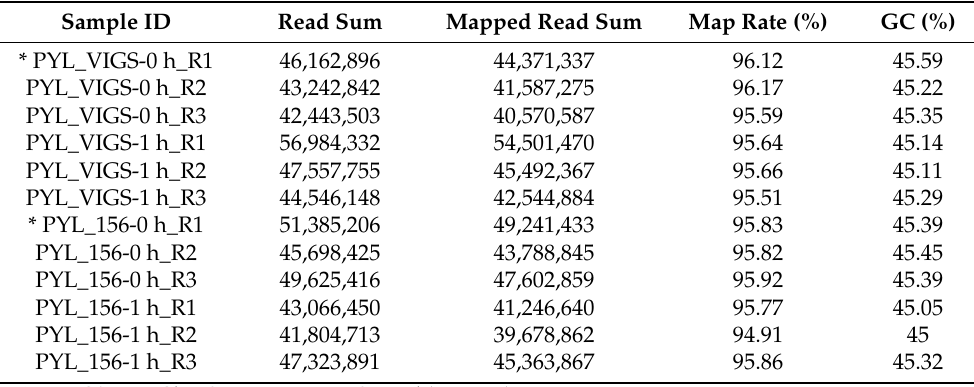
Table 1. Summary of 12 separately pooled RNA-sequencing read counts, using Gossypium hirsutum as a reference